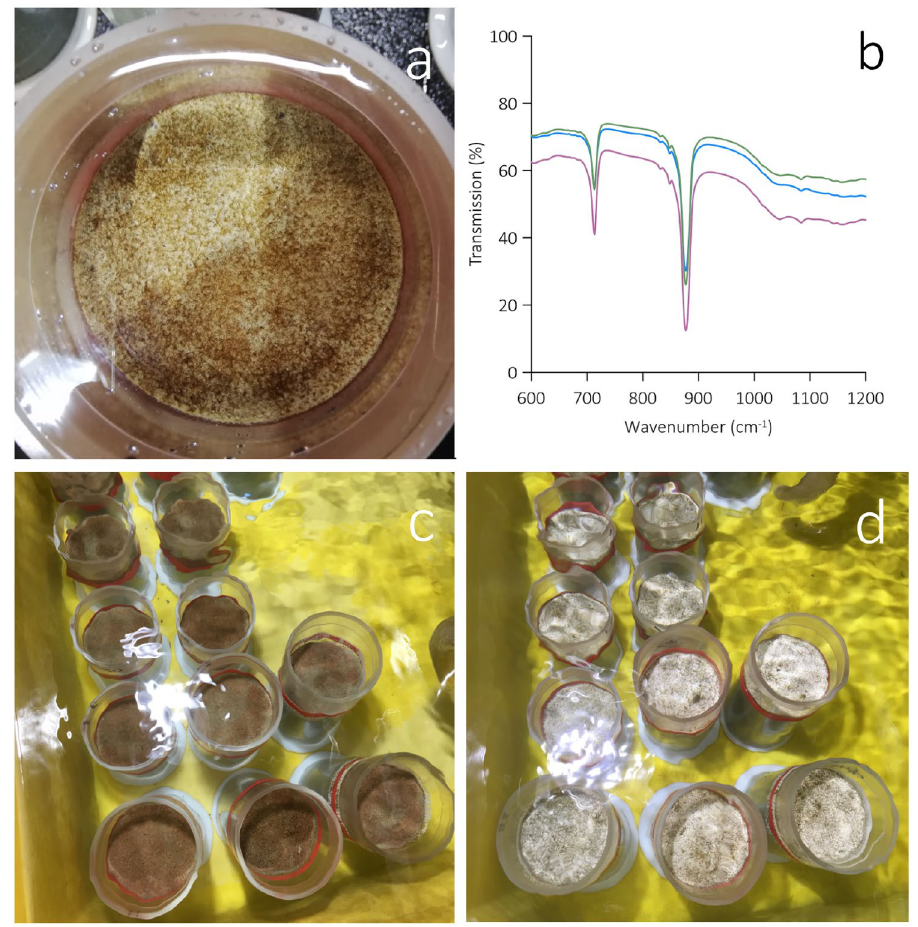
Figure 1. Photographs showing surfaces of intact cores of the subtidal silt sediment submerged in natural, recirculating seawater. The dark areas at the surface of the cores in ( a ) indicate the presence of pinnate diatoms. The three replicate Fourier Transform Infrared (FTIR) spectra of ground oyster shell granules in ( b ) indicate absorption peaks around 877 and 713 cm −1 . These are due to vibrations of the carbon–oxygen double bond in the carbonate ion of calcite, confirming that the ground oyster shells are primarily composed of calcite. The cores in ( c, d ) received a 1-mm surface layers of ( c ) sterile carbonate free sand (Control) or ( d ) calcite (ground oyster shells;